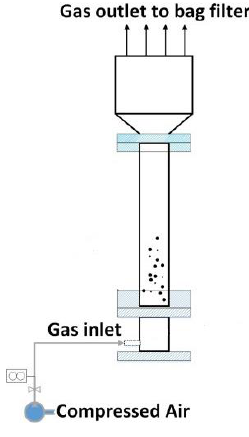
Figure 3. Schematic diagram of fluidized bed.